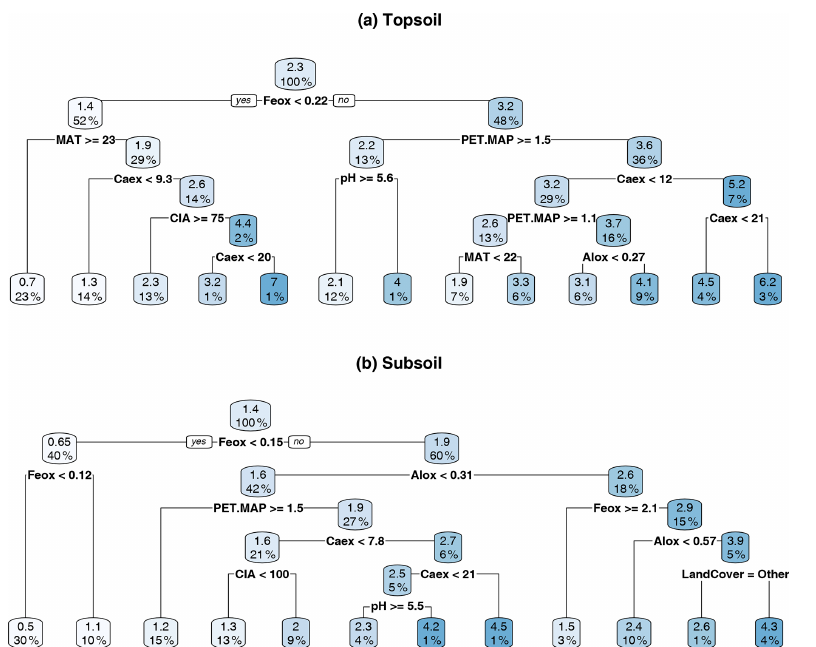
Figure A6. Regression tree for (a) topsoil (0–20cm) and (b) subsoil (20–50cm). Splitting values are always in the units of the parameter used for the split (for units, see Table 1). Absolute values in the boxes indicate the predicted soil organic carbon (SOC) content (wt%). The percentage corresponds to the relative number of